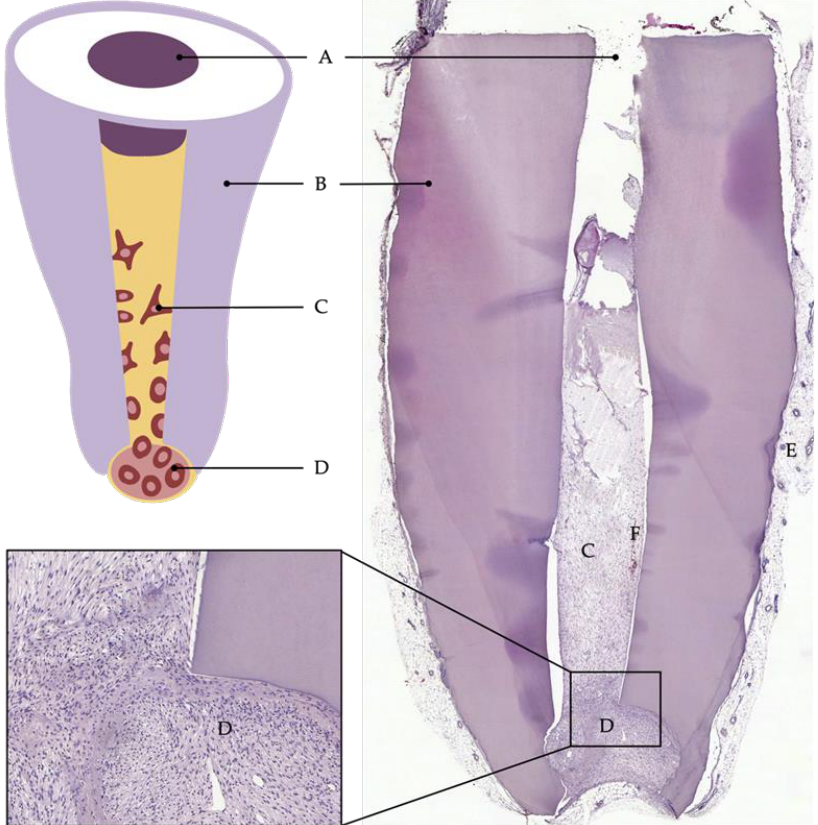
Figure 5. Cell-homing model. Tooth root recovered after 6 weeks of implantation into subcutaneous dorsal space of mice: ( A ) coronal plug, ( B ) dentin of root walls, ( C ) cells that migrated into the root canal, ( D ) apical reservoir of stem cells in collagen, ( E ) murine tissue, ( F ) blood vessel.